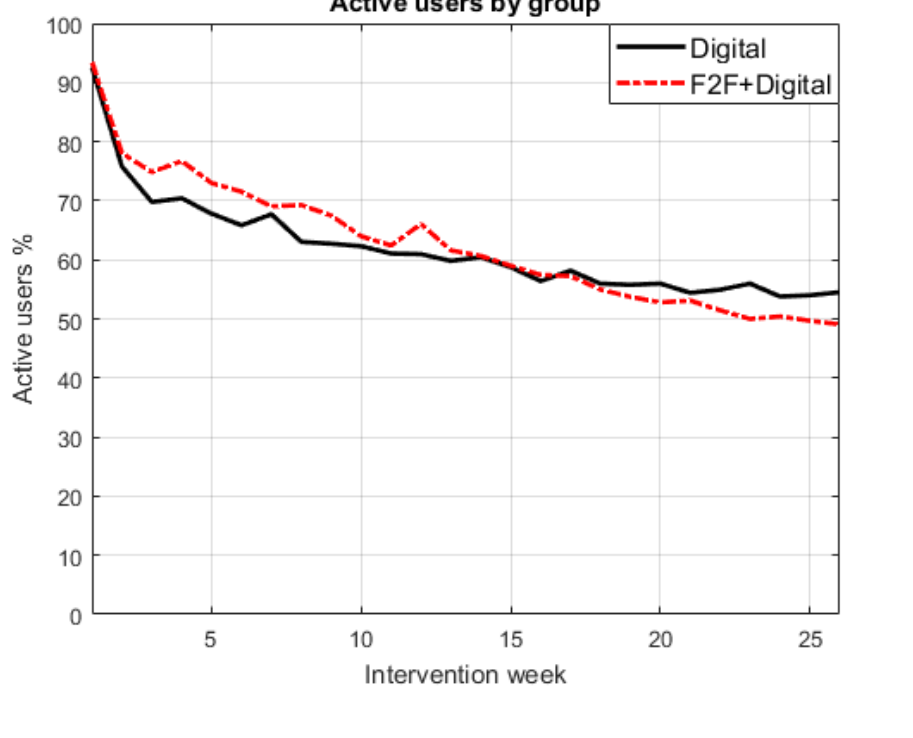
Figure 5. Percentage of active users per intervention week.